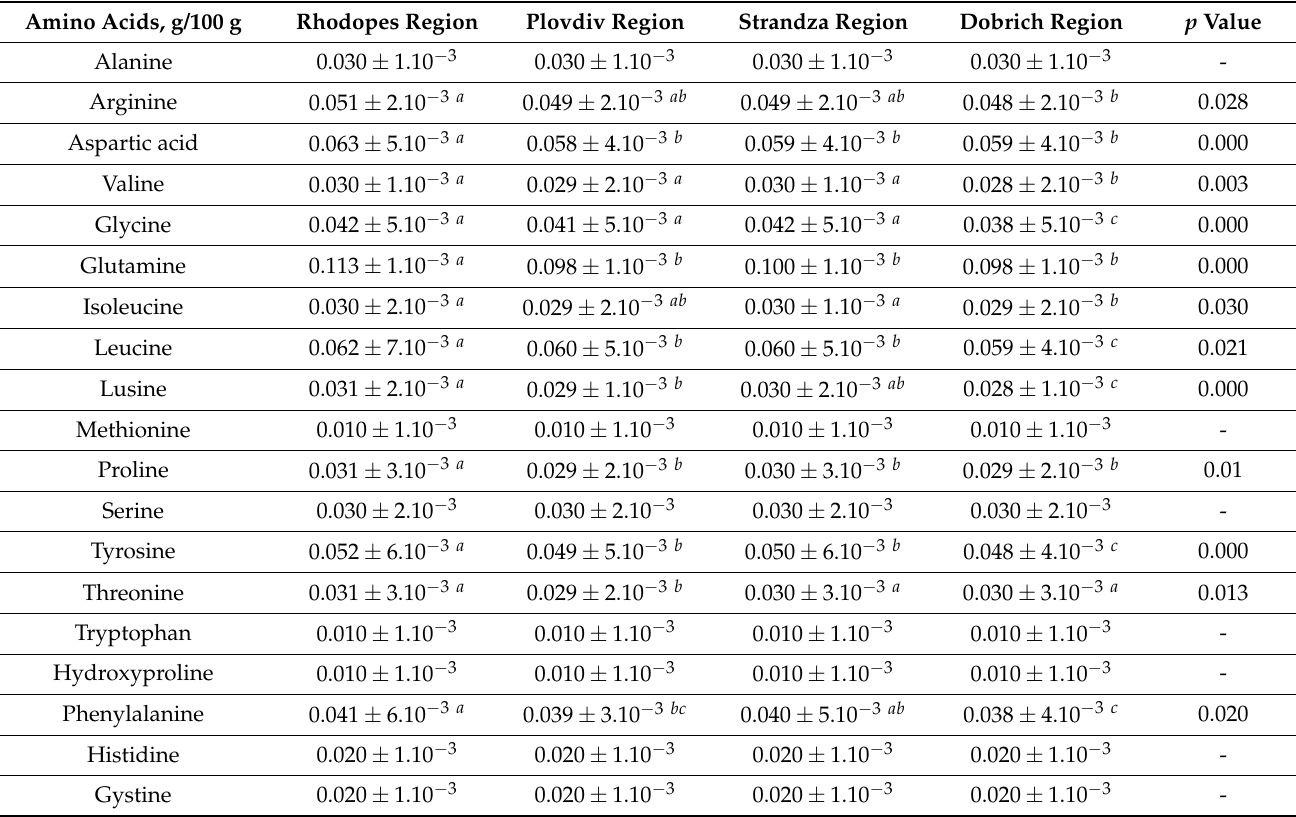
Table 4. Amino acid composition of Sambucus nigra L. blossoms from different regions in Bulgaria.